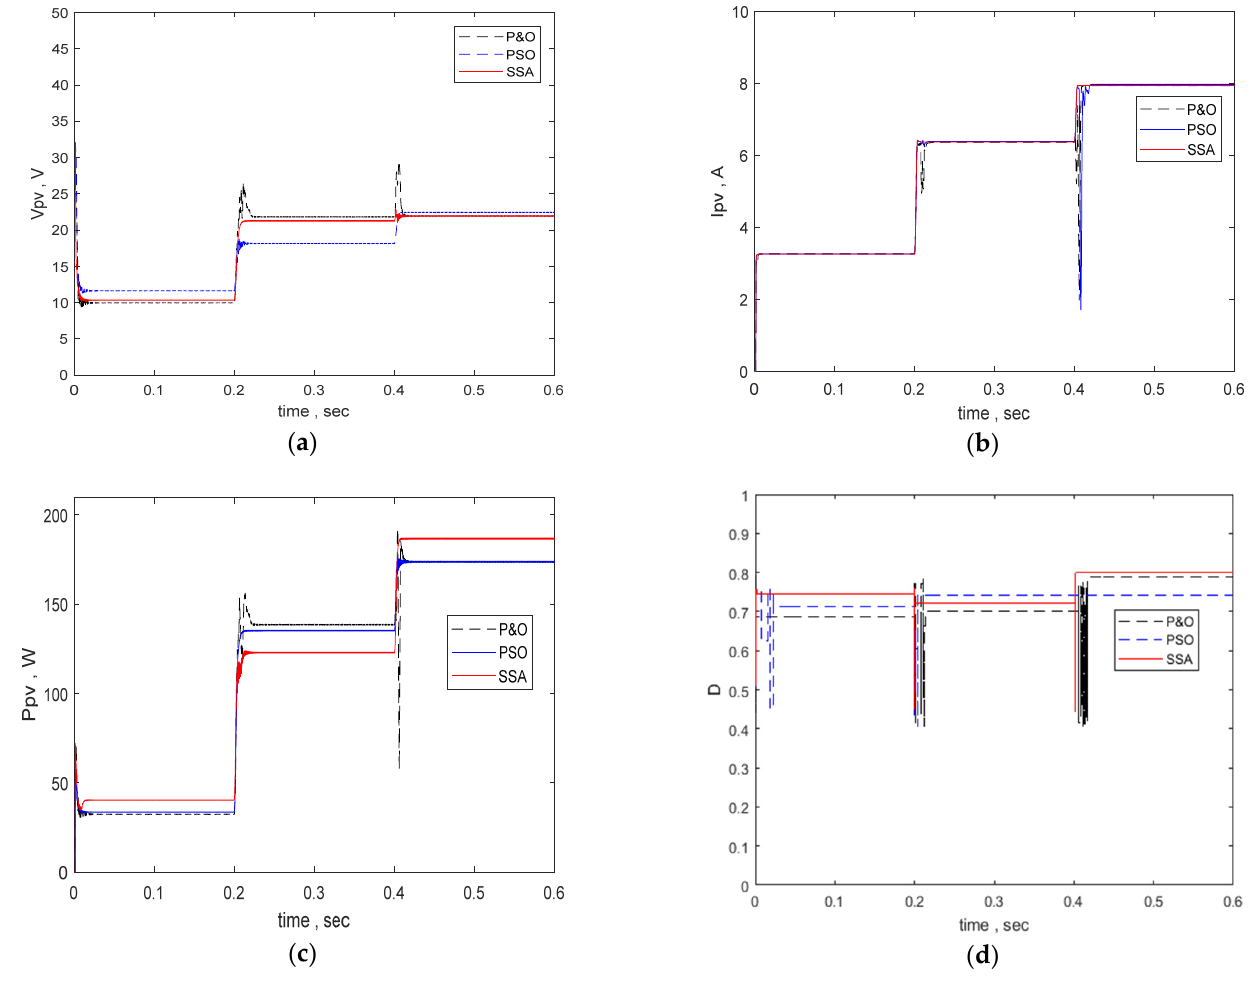
Figure 12. Load change from 1 Ohm to 1.7 Ohm, holding radiation intensity and temperature